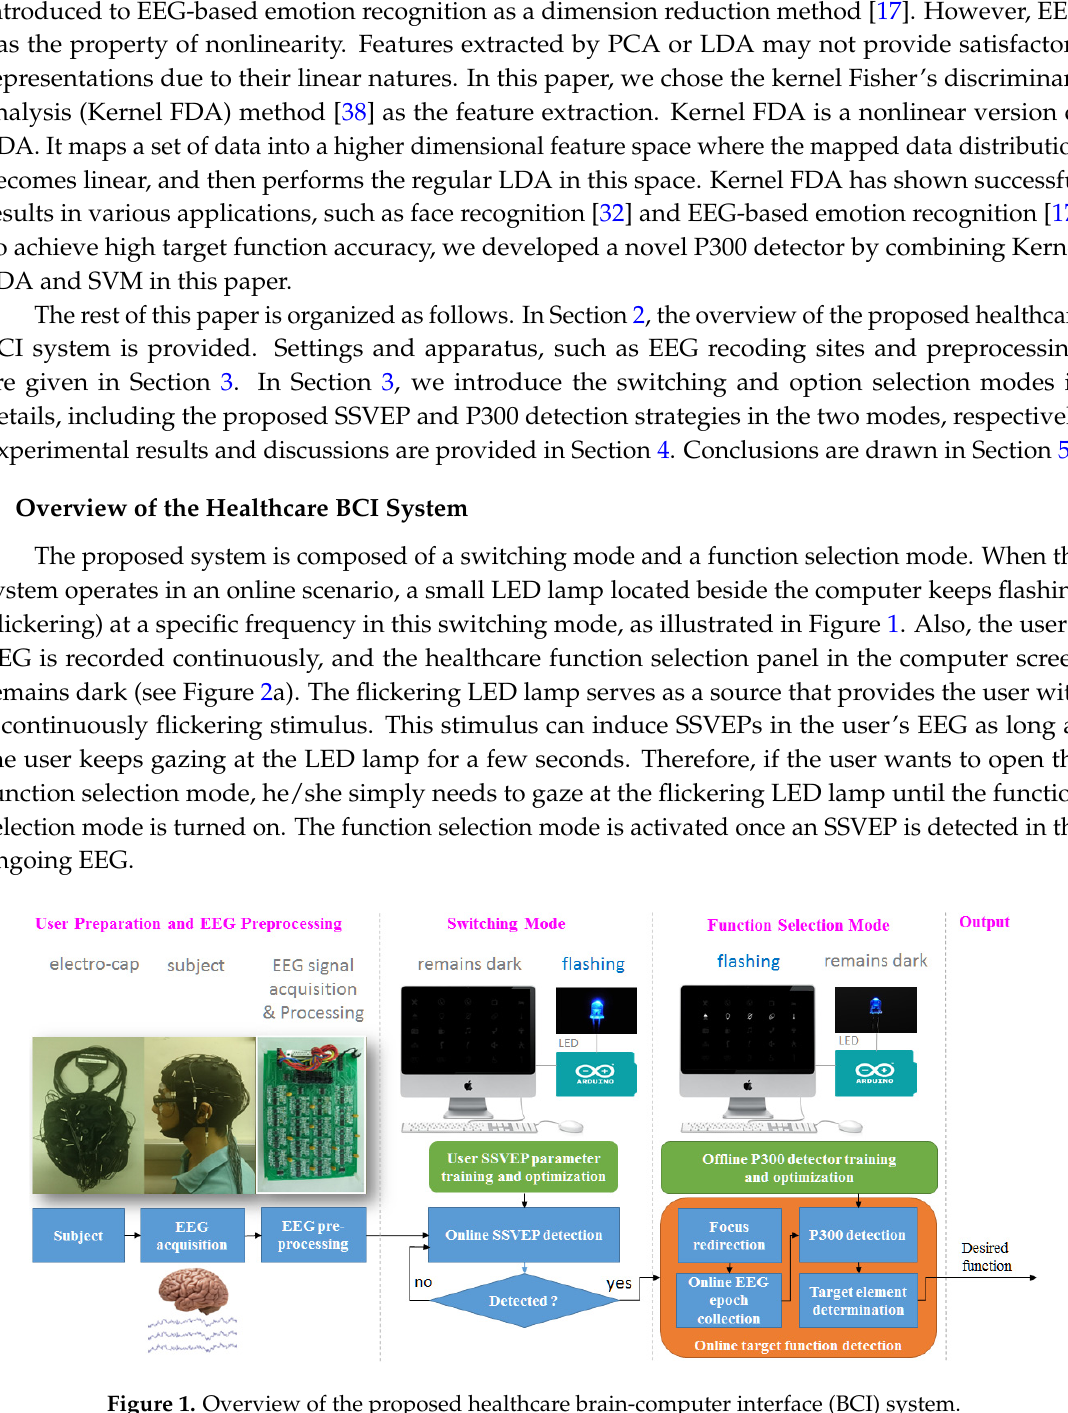
Figure 1. Overview of the proposed healthcare brain ‐ computer interface (BCI) system.